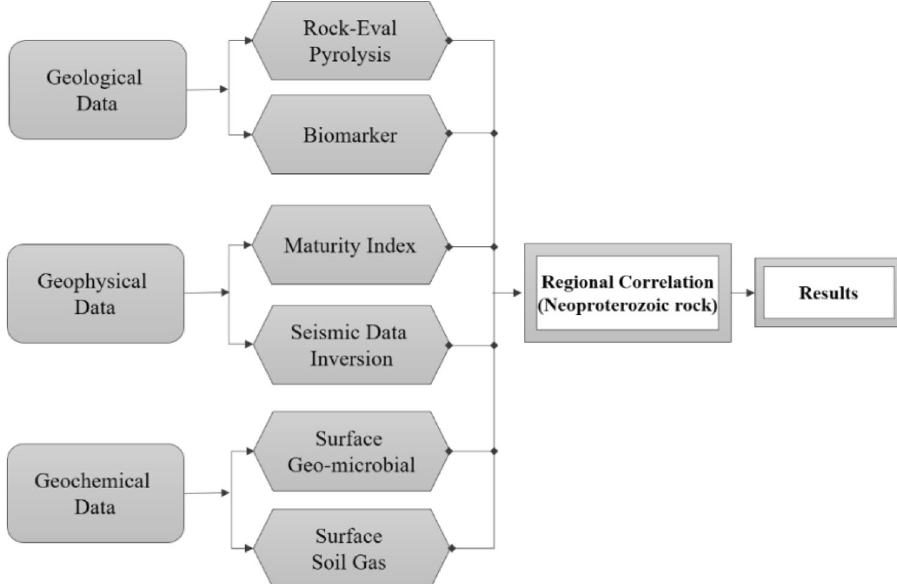
Figure 4. Flow chart of the methodology.